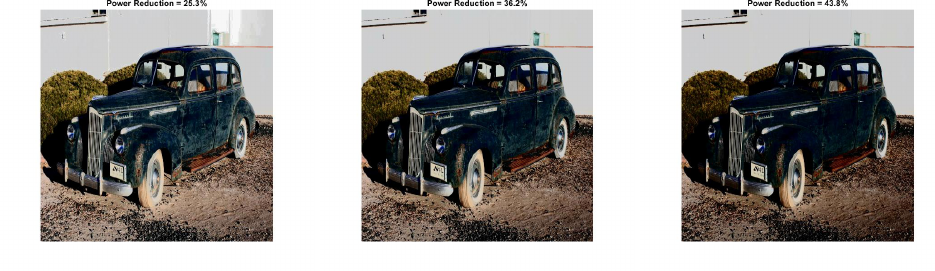
Figure 14. Car resulted image I new using Y CBCS (with HE) for a = 1 and b =